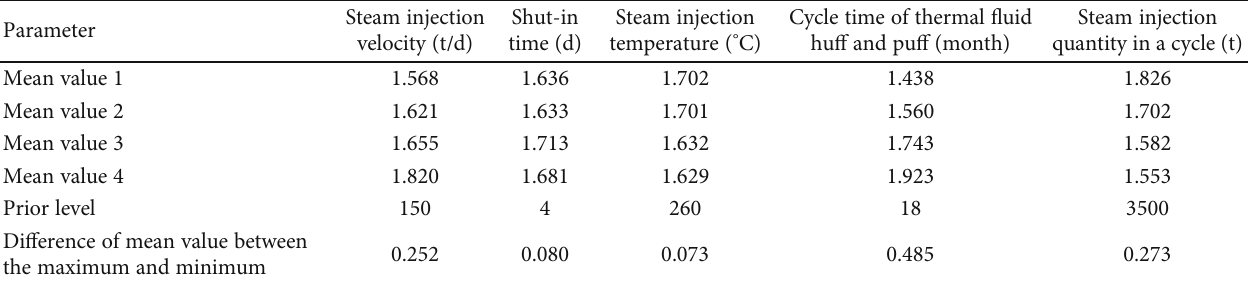
Table 7: Intuitive analysis table of B30 well in thermal recovery experiment.